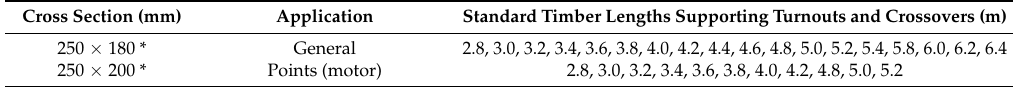
Table 2. Timber design for railway turnout applications [3].